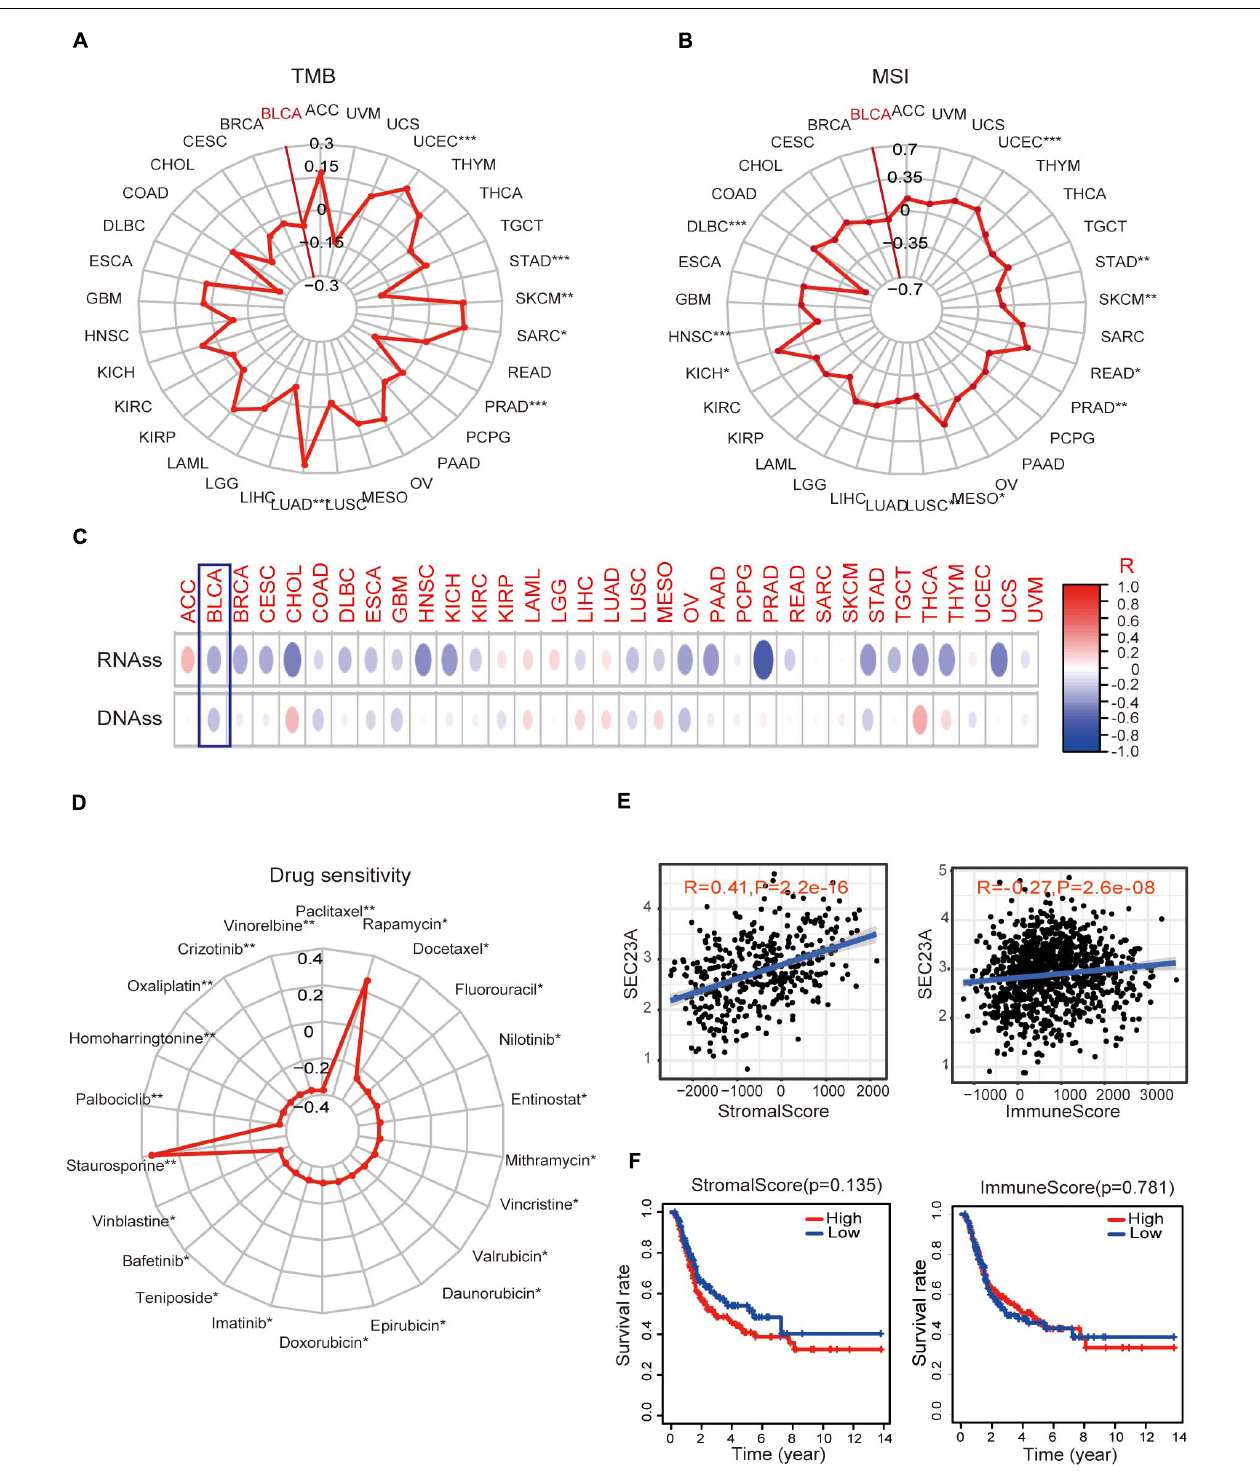
FIGURE 3 | Association of SEC23A expression with TMB, MSI, stemness score, drug sensitivity, and TME. (A,B) No significant correlations between SEC23A expression level and TMB and MSI in Pan-cancer patients, even though the p -value was statistically significant ( p *** < 0.001; p ** < 0.01; and p * < 0.05). (C,D) No significant correlations between SEC23A expression level and cancer stem cells and drug sensitivity (Antitumor agents) even though the p -value was statistically significant ( p *** < 0.001; p ** < 0.01; and p * < 0.05). (E) SEC23A expression level significantly correlated with Stromalscore and Immunescore. (F) Survival analysis of SEC23A associated with levels of Stromalscore and Immunescore. Pearson correlation was applied to analyze the correlation.